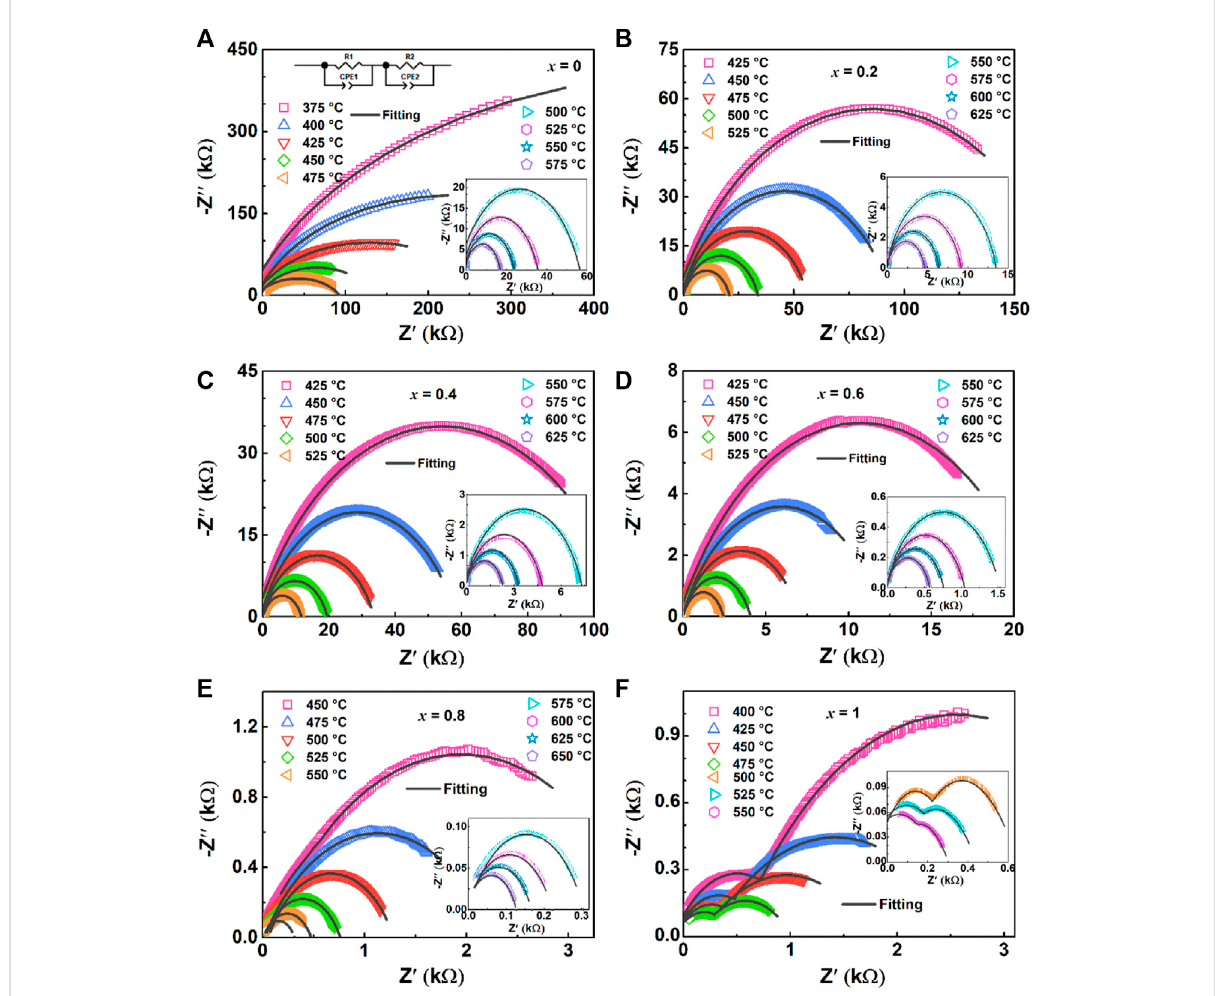
FIGURE 8 (Color online) Complex impedance spectra for (1- x ) BBT — x BiT ceramics at various temperatures: (A) BBT, (B) 0.8BBT-0.2BiT, (C) 0.6BBT- 0.4BiT, (D) 0.4BBT-0.6BiT, (E) 0.2BBT-0.8BiT, and (F)